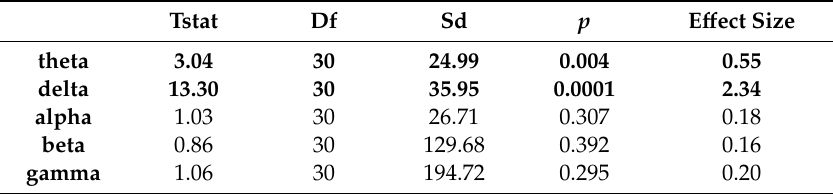
Table 3. t -test table for the frontal region (all bands) of the HERA model. Tstat